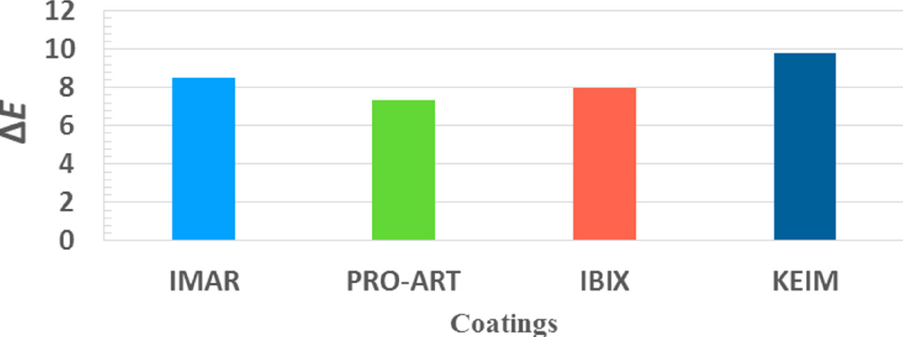
Figure 6. Colorimetric measures averaged for all paints four months after the application of coatings.